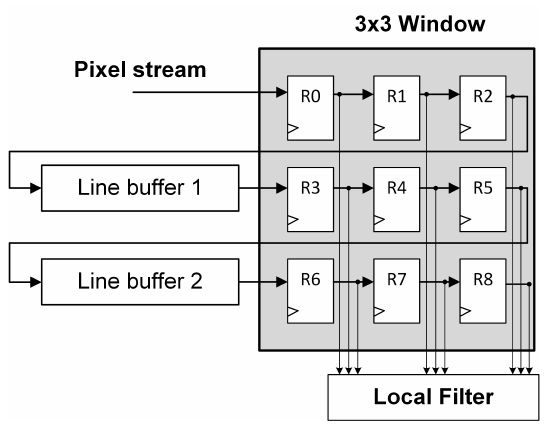
Figure 2. Line buffer pipeline in series with window.